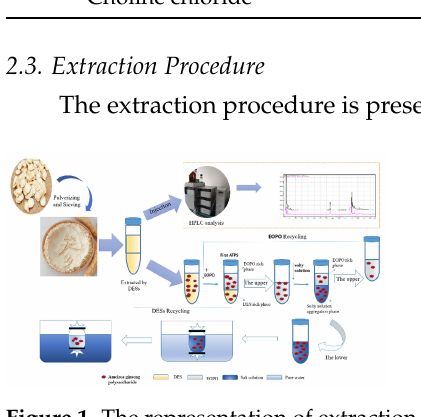
Figure 1. The representation of extraction